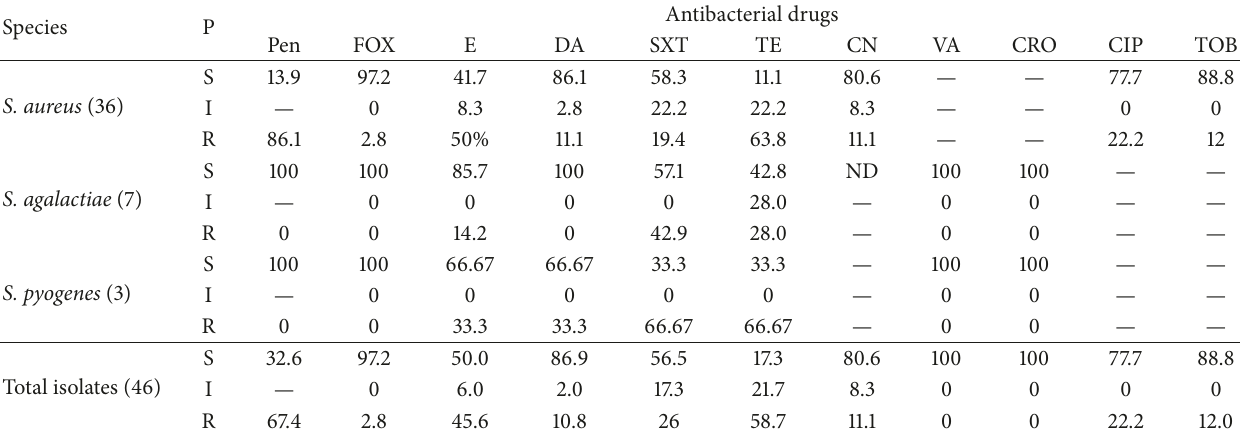
Table 3: Percentage of in vitro antibacterial susceptibility pattern of Gram-positive bacteria isolates ( 𝑛 = 46 ). Species